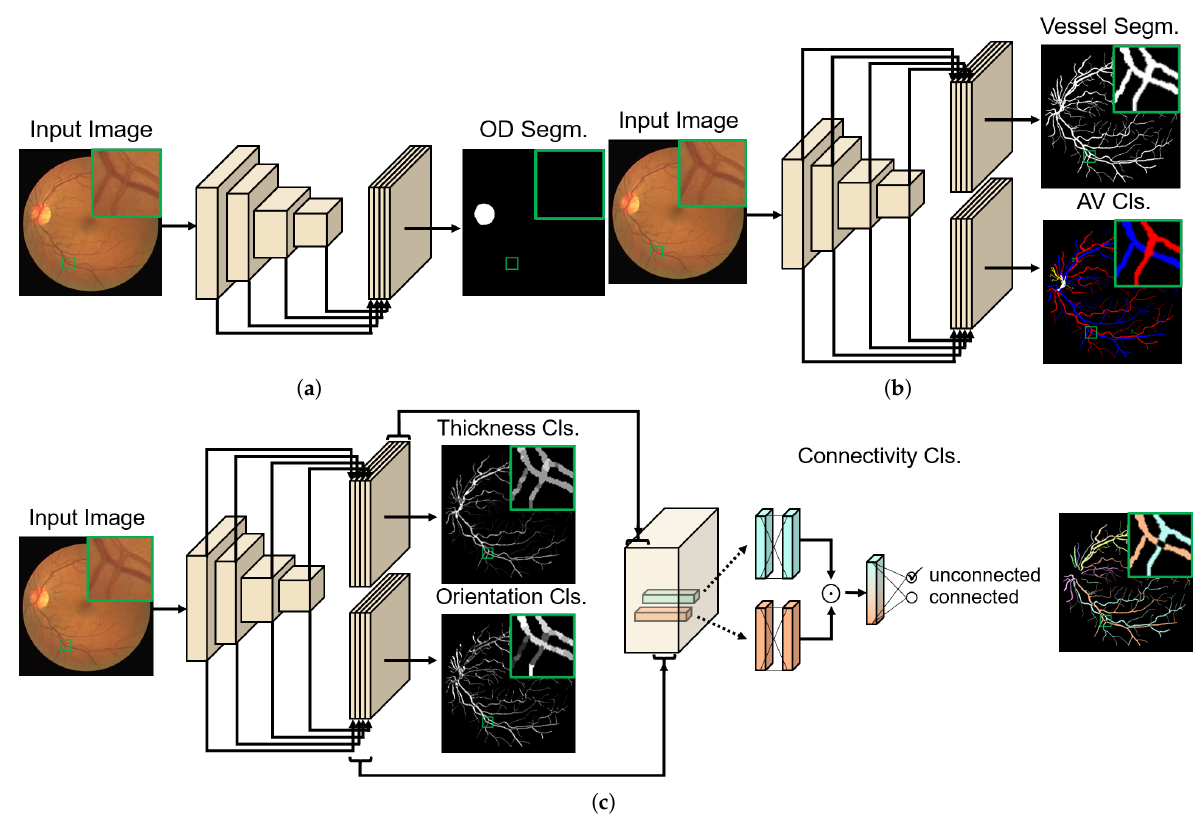
Figure 3. Three networks for topology-aware AV classification. For each network, an input image and the corresponding ground-truth (GT) image for training are presented. For all three component networks, we adopt the network of [7] as the backbone network. ( a ) Network for optic disc segmentation (OD segm.). ( b ) Multi-task network for binary vessel segmentation and AV classification (cls.), which is composed of one shared encoder and two separate decoders for each task. ( c ) Network for vascular connectivity classification, including multi-task auxiliary outputs for thickness/orientation classifications. To ensure the symmetry of this pairwise classification, a Hadamard product symbolized by (cid:12) is used on the 256-dim outputs of a fully connected layer applied on the concatenated thickness/orientation features. This is followed by the final fully connected inference layer. The connectivity GT label for training is decided from the rightmost topology GT. Note that different intensity values in the thickness/orientation GTs represent different classes. Different colors in the topology GT represent separate sub-trees. Further details regarding the network can be found in Section